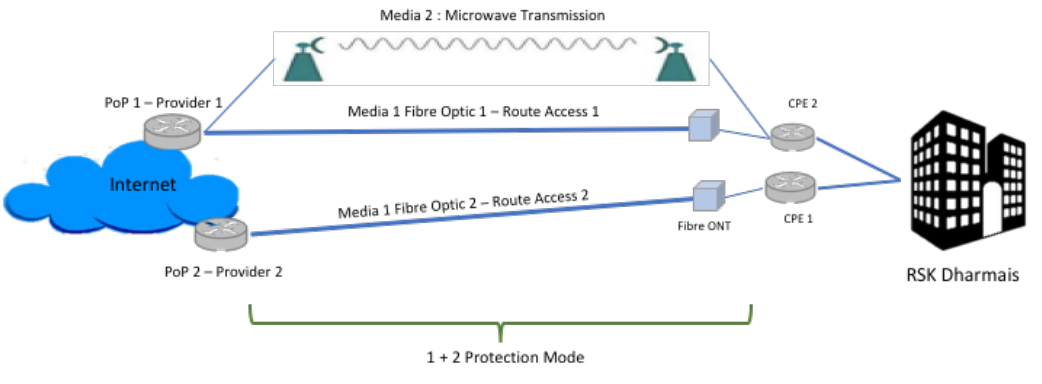
Figure 13. Target Network Access Redundancy Diagram.